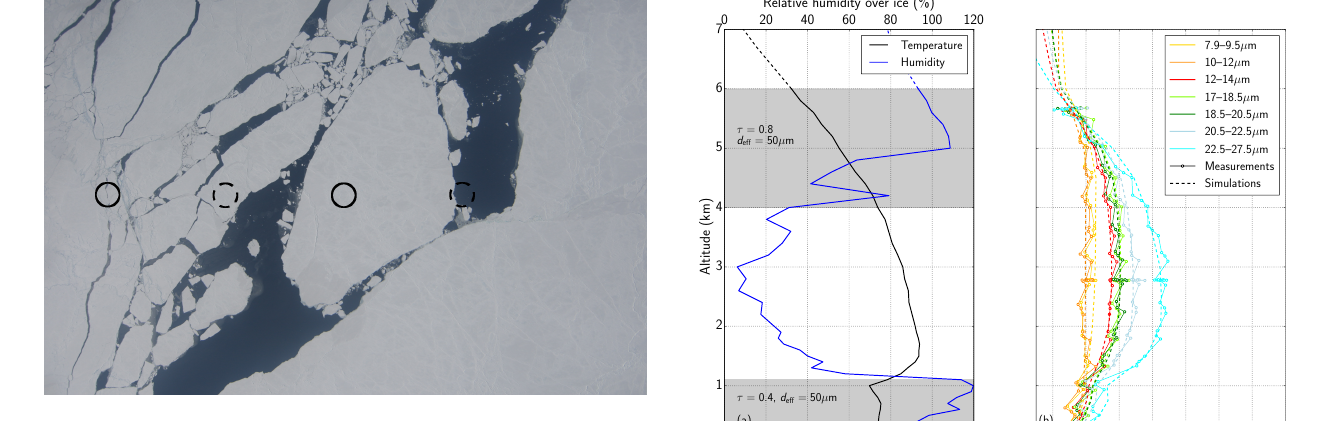
Figure 10. Downward picture of the surface taken on 21 April at 17:35UTC and 3.8km altitude. The 300m diameter circles depict the FIRR footprint at the surface for a single 0.8s measurement. Plain line circles indicate the relative positions of the aircraft when the measurement is performed on the first filter, and dashed circles when performed on the last filter (flight direction is to the right). It takes approximately 20s to measure all nine filters and another 20s to come back to the position of the first filter.